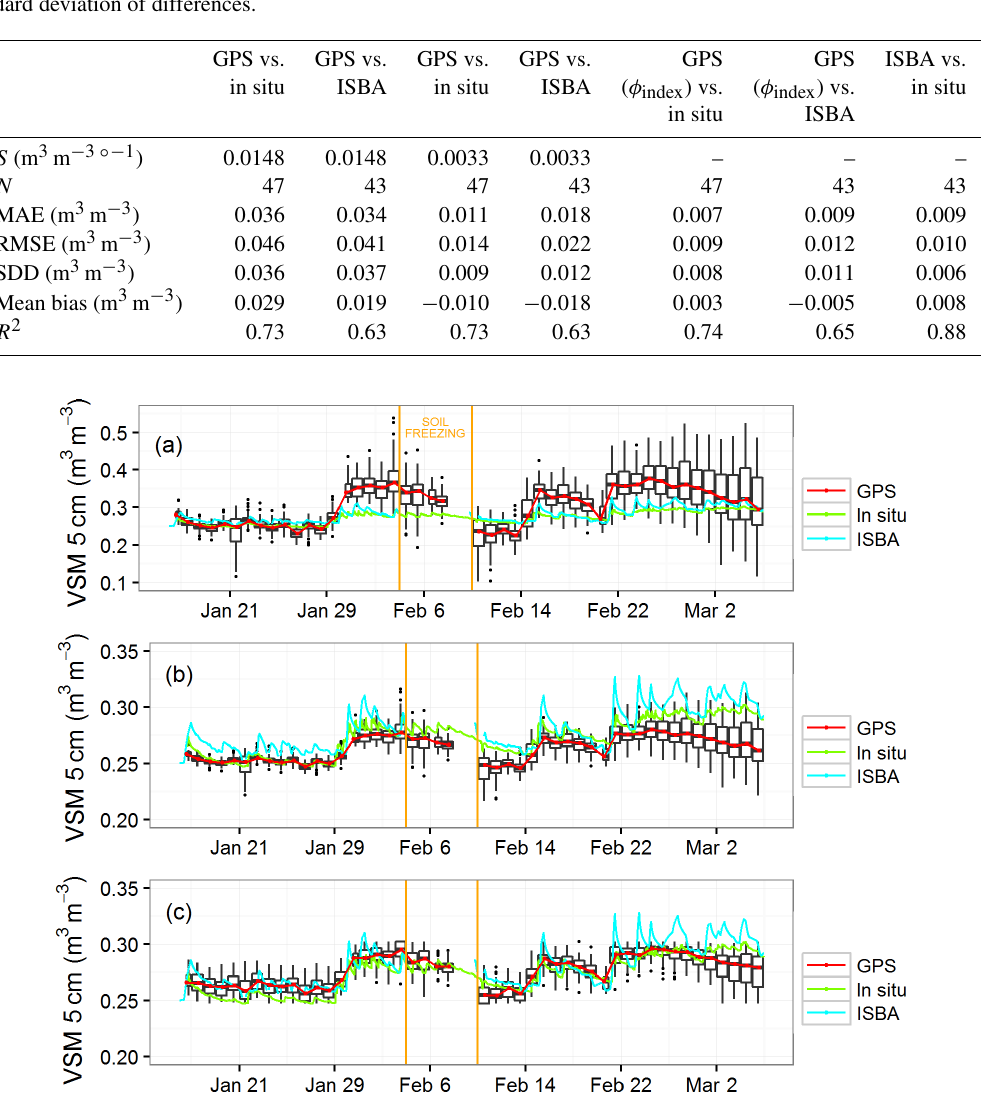
Figure 3. In situ surface volumetric soil moisture (VSM) observations at 5cm depth (green line), ISBA simulations (blue line) and median of the daily GPS retrievals (a) with the a priori slope ( S = 0.0148m 3 m − 3 ◦− 1 ) (red line), (b) with a locally adjusted slope ( S = 0.0033m 3 m − 3 ◦− 1 ) (red line) and (c) from scaled soil wetness index (red line), and their daily statistical distribution (black box plots) for all available satellite tracks from 16 January to 5 March 2015. Boxes: 25–75% percentiles; bars: maximum (minimum) values below (above) 1.5 IQR (Inter Quartile Range, corresponding to the 25–75% percentile interval); dots: data outside the 1.5 IQR interval. The ISBA simulations indicate soil freezing (i.e., the presence of ice in the top soil layer) from 4 to 9